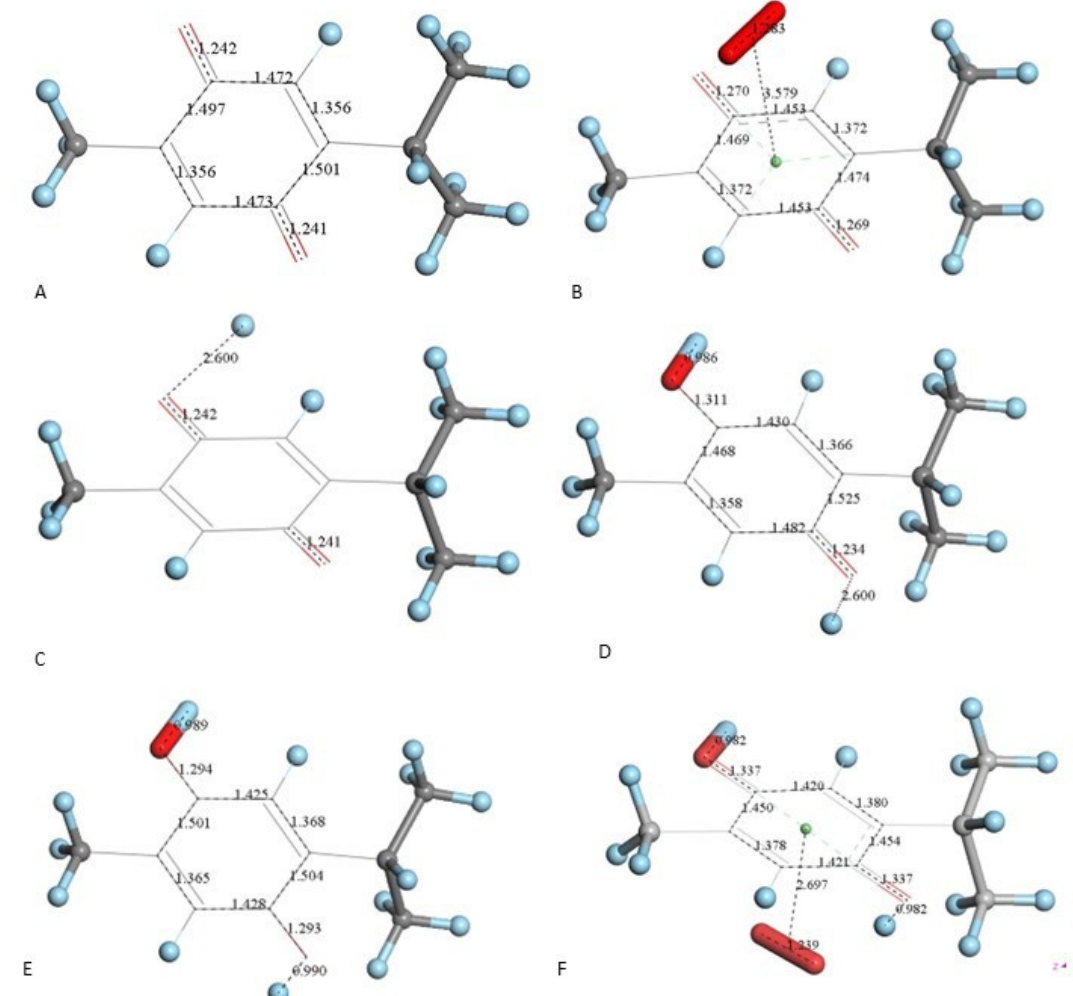
Figure 4. TQ superoxide scavenging DFT calculations. H atoms are light blue to avoid white background misperception. ( A ) Minimized TQ molecule obtained after input of corresponding X-ray coordinates. ( B ) Superoxide was π - π placed (3.50 Å) above ring shown in A, and upon DFT minimization both moieties became more distant, 3.579 Å, while ring C-C bond lengths were modified due to electron transferred from superoxide to the ring and O-O bond length shortens to 1.283 Å. ( C ) Structure shown in A has a proton van der Waals separated (2.60 Å) from one O(carbonyl). ( D ) DFT outcome of structure shown in C, plus an additional proton 2.60 Å separated from the second O(carbonyl). ( E ) DFT outcome of structure shown in D whose charge is 2+, showing two C ‐ OH moieties. ( F ) A superoxide radical was π‐π placed in E, and DFT shows formation of the radical [thymohydroquinone ‐η‐ O 2 ]• + , with separation between centroids of 2.697 Å.